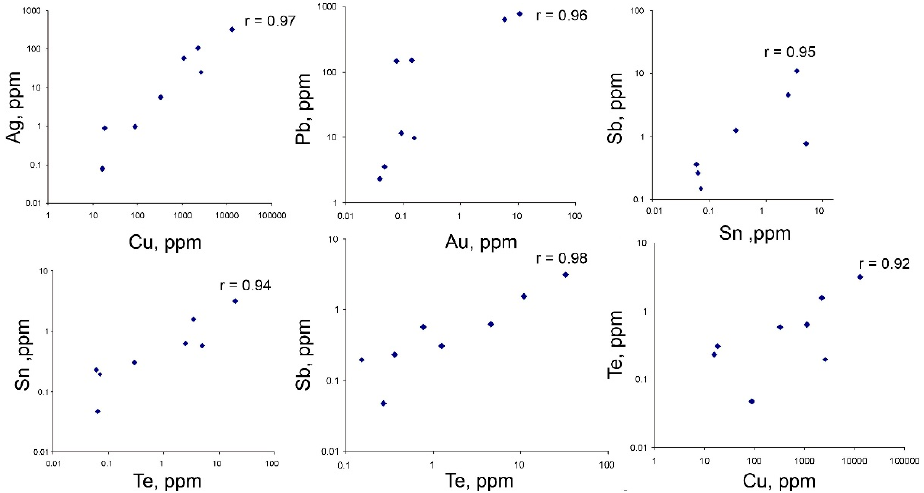
Figure 9. Log ‐ log plots for selected trace elements in clastic fine ‐ crystalline pyrite (ppm).